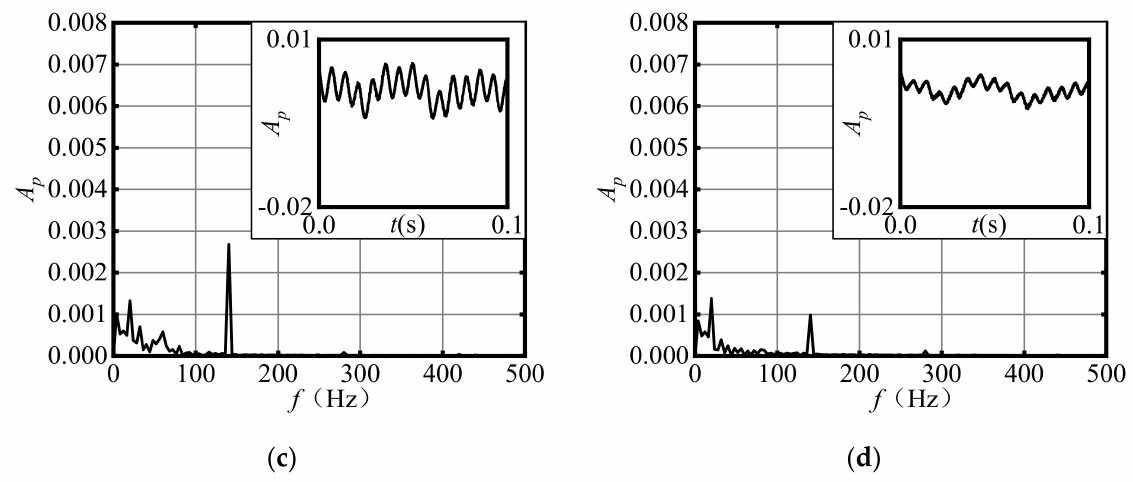
Figure 12. Comparison between CFD and experimental pressure pulsation at ϕ d . ( a ) Pa1; ( b ) Pa2; ( c ) Pa3; ( d )